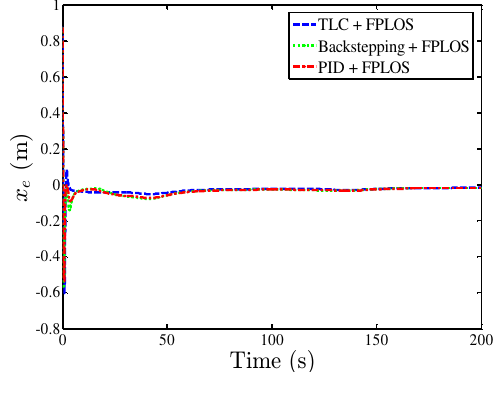
Figure 15. Along-track errors x e .